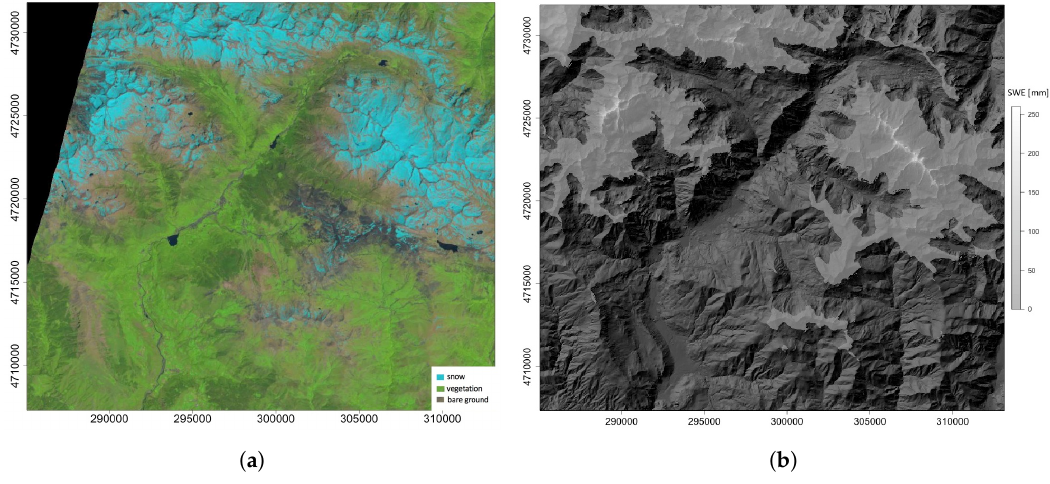
Figure 5. Snow height modelled and measured in three snow gauges (TN1, TN2 and TN3 in map in Figure 1) at the Ésera catchment. The lower panel is the result of a simpler temperature index model applied to the Renclusa site. The melt factor was computed as the best linear fit to previous 24 h accumulated positive degree days and corresponding melt. The calibration period was the week before the ROS event in this case the Nash-Sutcliffe efficiency value degrades to 0.89.